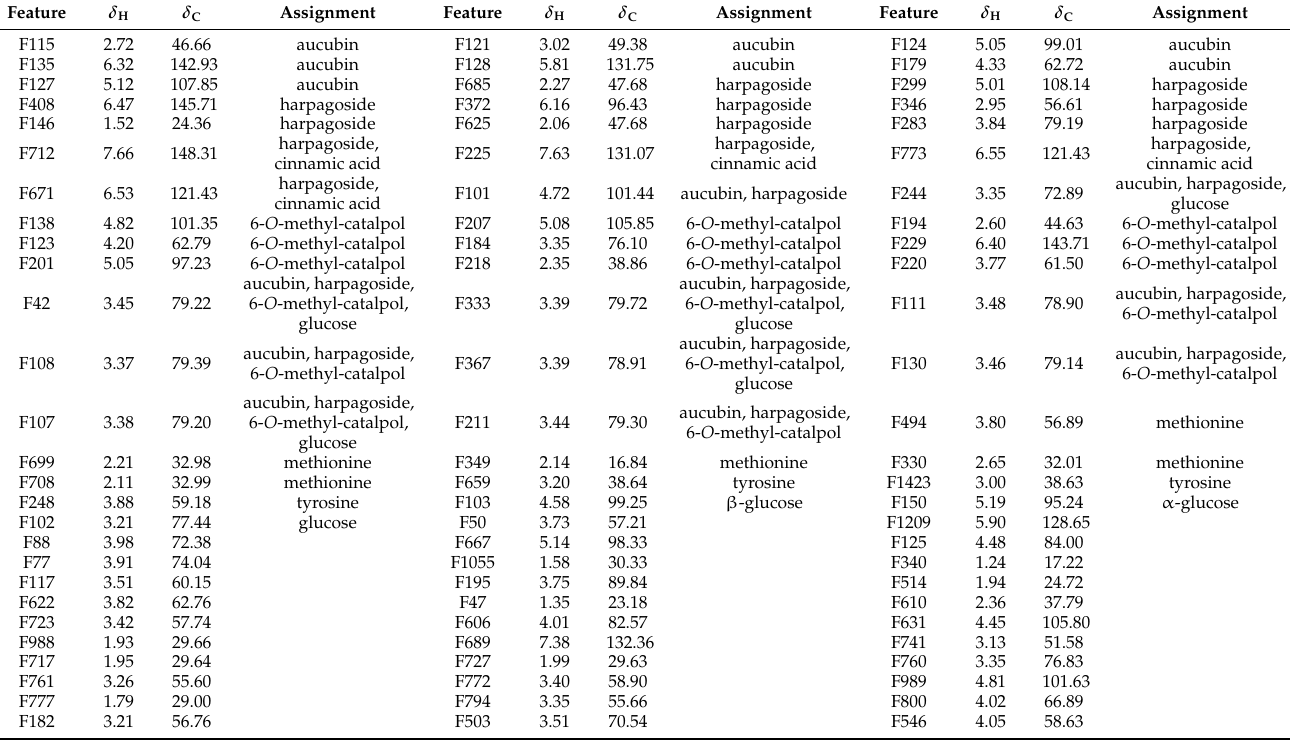
Table 2. Detailed information and assignments of the differential features (F) among differently processed SR with VIP > 1.0 and | p (corr)| > 0.8 by PLS-DA and p value < 0.01 by univariate